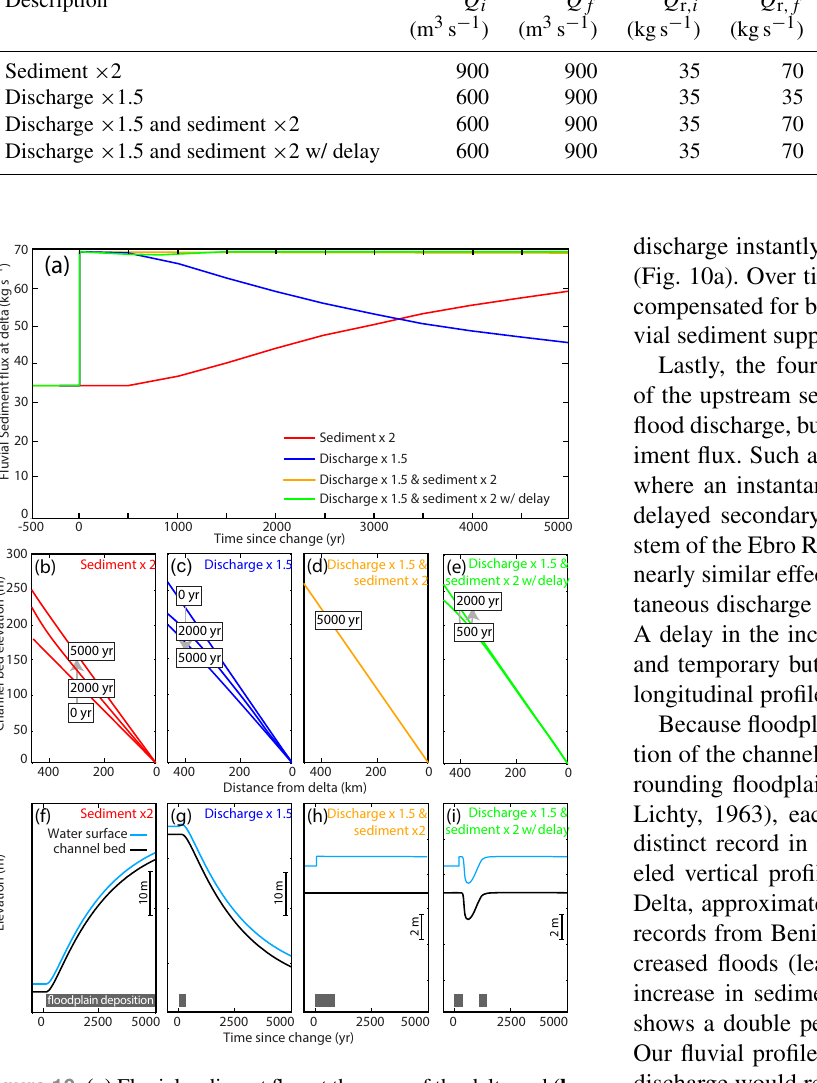
Figure 10. (a) Fluvial sediment flux at the apex of the delta and (b– e) longitudinal river profile evolution from four experiments of the river profile model with an increase in sediment supply (red), flood discharge (blue), sediment supply and flood discharge (orange), and flood discharge with a lagged sediment supply (green). (f–i) Time evolution of the channel bed and water surface elevation through time, 200km upstream of the delta at the approximate location of the floodplain records from Benito et al. (2008). Note the different scales between (f–g) and (h–i) . Expected occurrence of floodplain deposits (period of increasing water surface elevation) shown by the gray